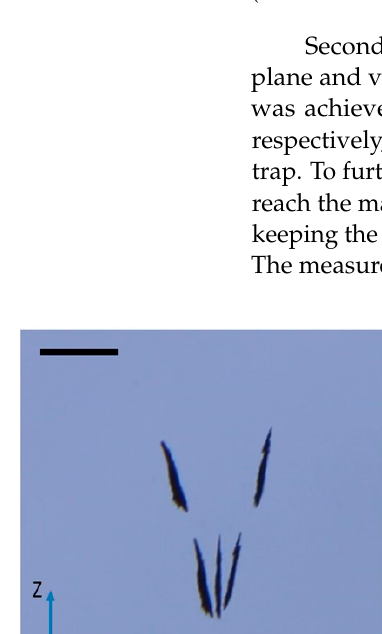
Figure 11. Demonstration of rotation control in the O ‐ XZ plane: ( a ) Time ‐ lapse image sequences show a nanocarrier cluster in the O ‐ XZ plane (viewed from front) rotated along the X ‐ axis then keeping the orientation and moving forward (scale bar is 1 mm); ( b ) Counterclockwise and clock ‐ wise angles along the X ‐ axis for 10 and 50 V between two sides of the tweezers.